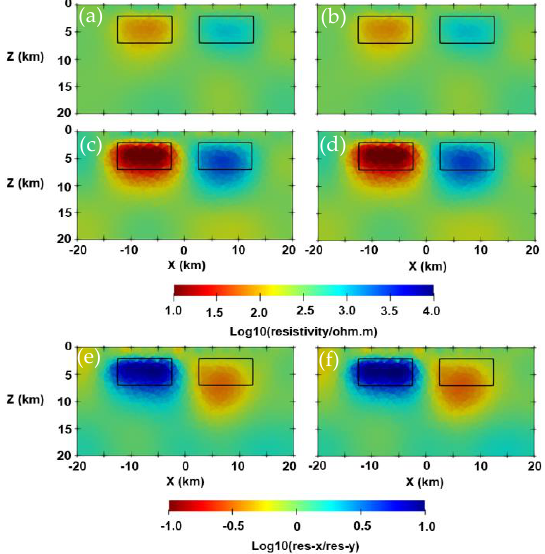
Figure 15. Anisotropic inversion results at y = 0 km. Panels ( a ) and ( b ) show the inverted resistivity in the principal X direction when including and excluding the vertical resistivity in the inversion. Panels ( c ) and ( d ) show the inverted resistivity in the principal Y direction when including and excluding the vertical resistivity in the inversion. Panels ( e ) and ( f ) show the inverted anisotropic coefficient when including and excluding the vertical resistivity in the inversion.